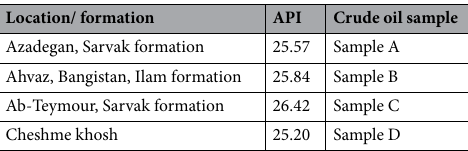
Table 1. location and API density of crude oil